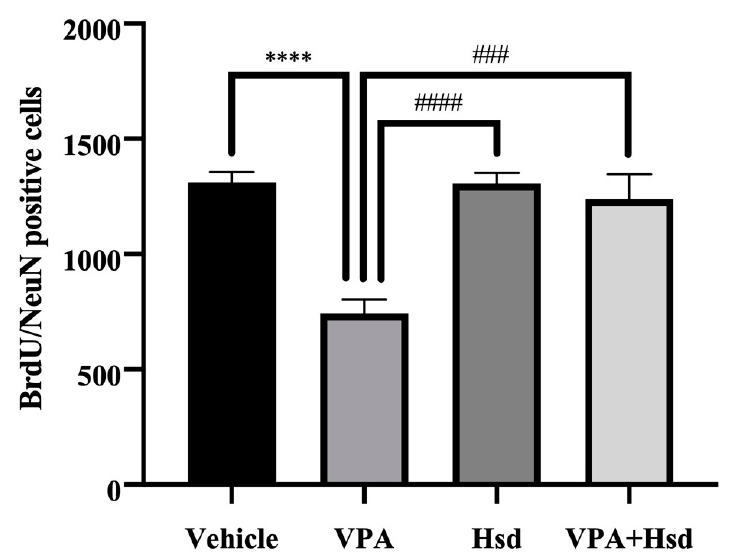
Figure 8. The mean BrdU-positive cell count of the VPA-treated group was significantly reduced compared to the vehicle (**** p < 0.0001), Hsd (#### p < 0.0001), and VPA+Hsd (### p < 0.001) groups.